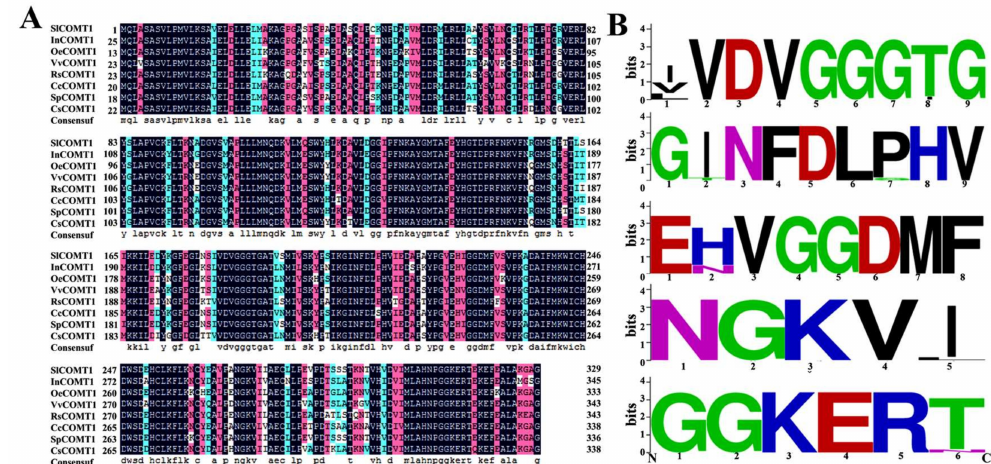
Figure 3. Evolution relationship of SlCOMT1 with other COMT proteins. ( A ) Comparison of amino acid sequences between tomato SlCOMT1 and COMT from other species, including In , Ipomoea nil (BAE94400.1); Oe , Olea europaea (XP_022844536.1); Vv , Vitis vinifera (XP_003634161.1); Rs , Rauvolfia serpentine (AOZ21153.1); Cc , Capsicum chinense (BAR88175.1) ; Sp , Solaum pennellii (XP_015070697.1); and Cs , Camellia sinensis (ADN27527.1); ( B ) Five conserved domains of the COMT proteins.